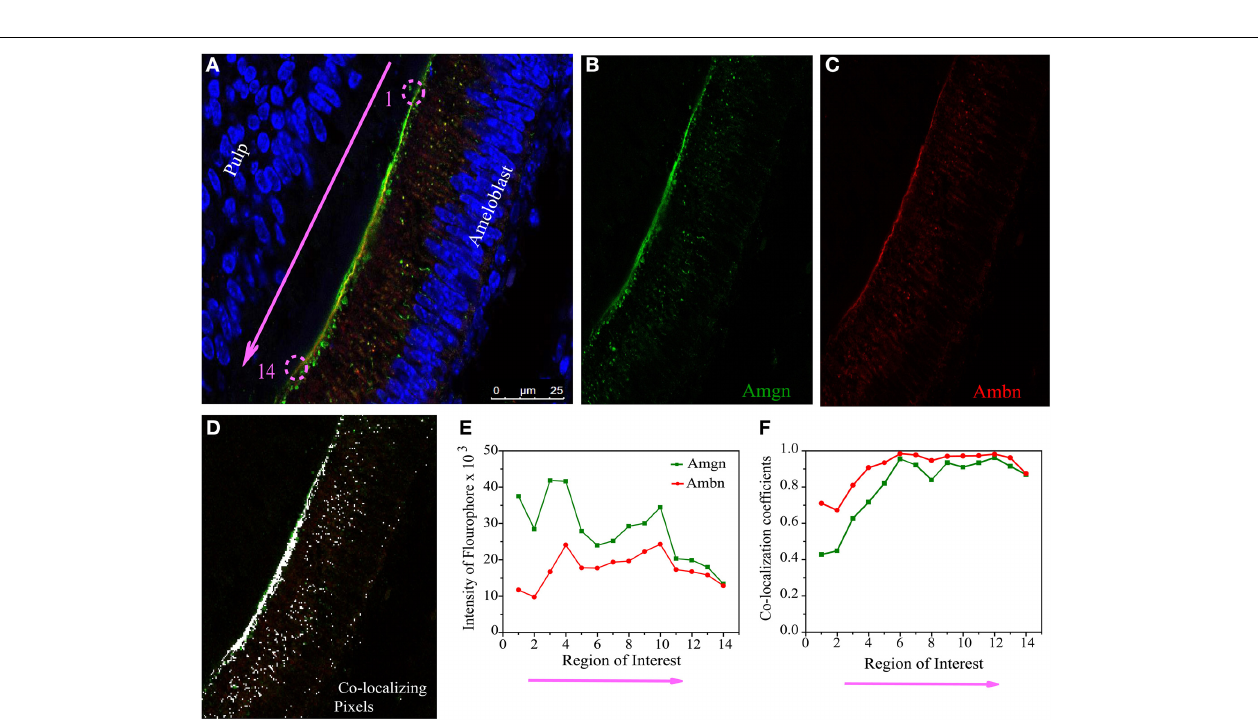
FIGURE 5 | Quantitative co-localization of ameloblastin and amelogenin in mouse molar enamel at P1. (A) Confocal image with higher magnification taken from the sample in Figure 4A (see square), considered for QCA analysis along the enamel surface (pink arrow). The individual channels detecting (B) only Amgn and (C) only Ambn signal. (D) Represent